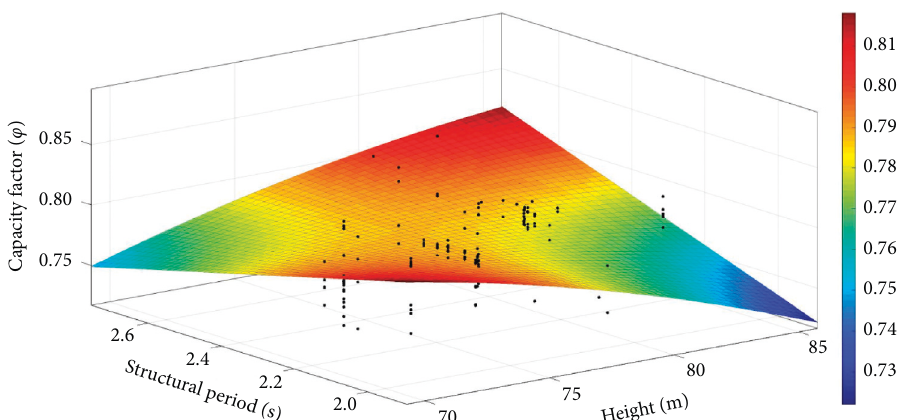
Figure 6: Capacity factor vs height and structural vibration period, corresponding to β �